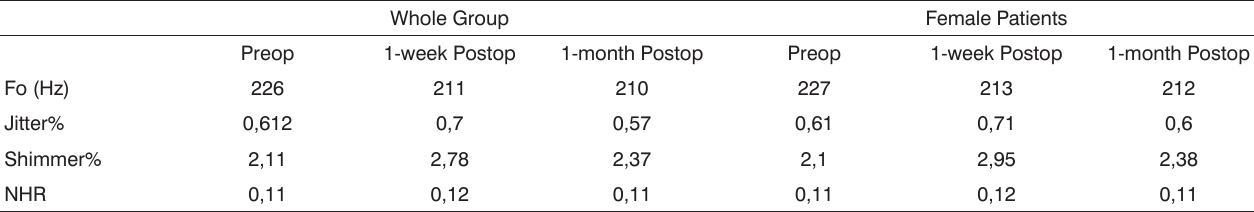
Table 3. Voice acoustic evaluation parameters - whole group and female